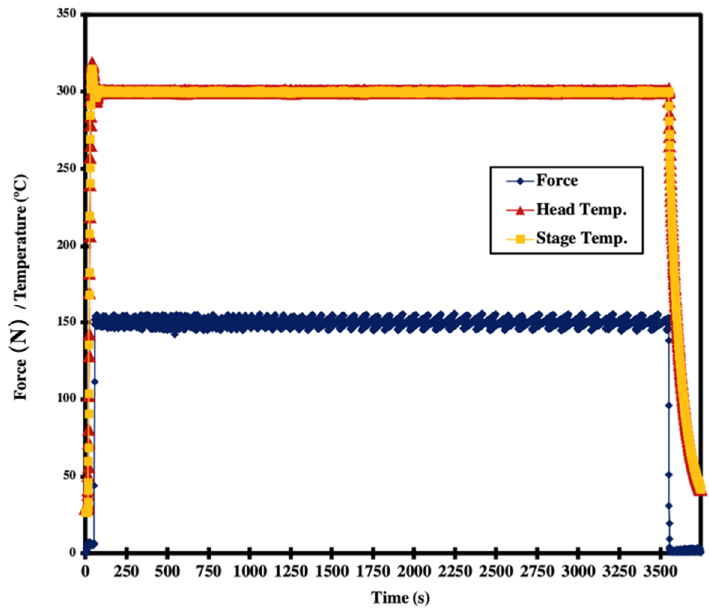
Figure 10. Process profile of temperature and bonding force vs. bonding time under the second step (post-annealing) process.